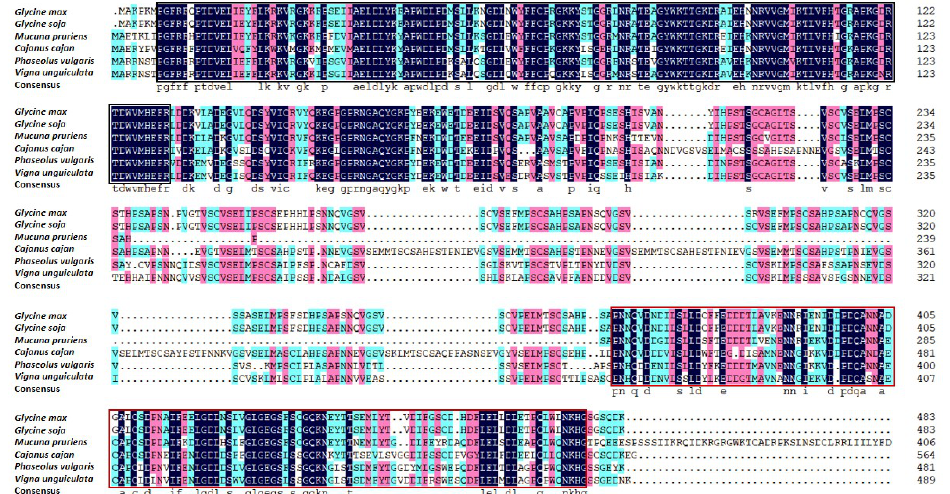
Figure 4. Comparative sequence analysis of GmNAC3 protein and four NAC proteins in five legu- minous species based on DNAMAN. The NAM and the activation domains are indicated by the black and red boxes, respectively.